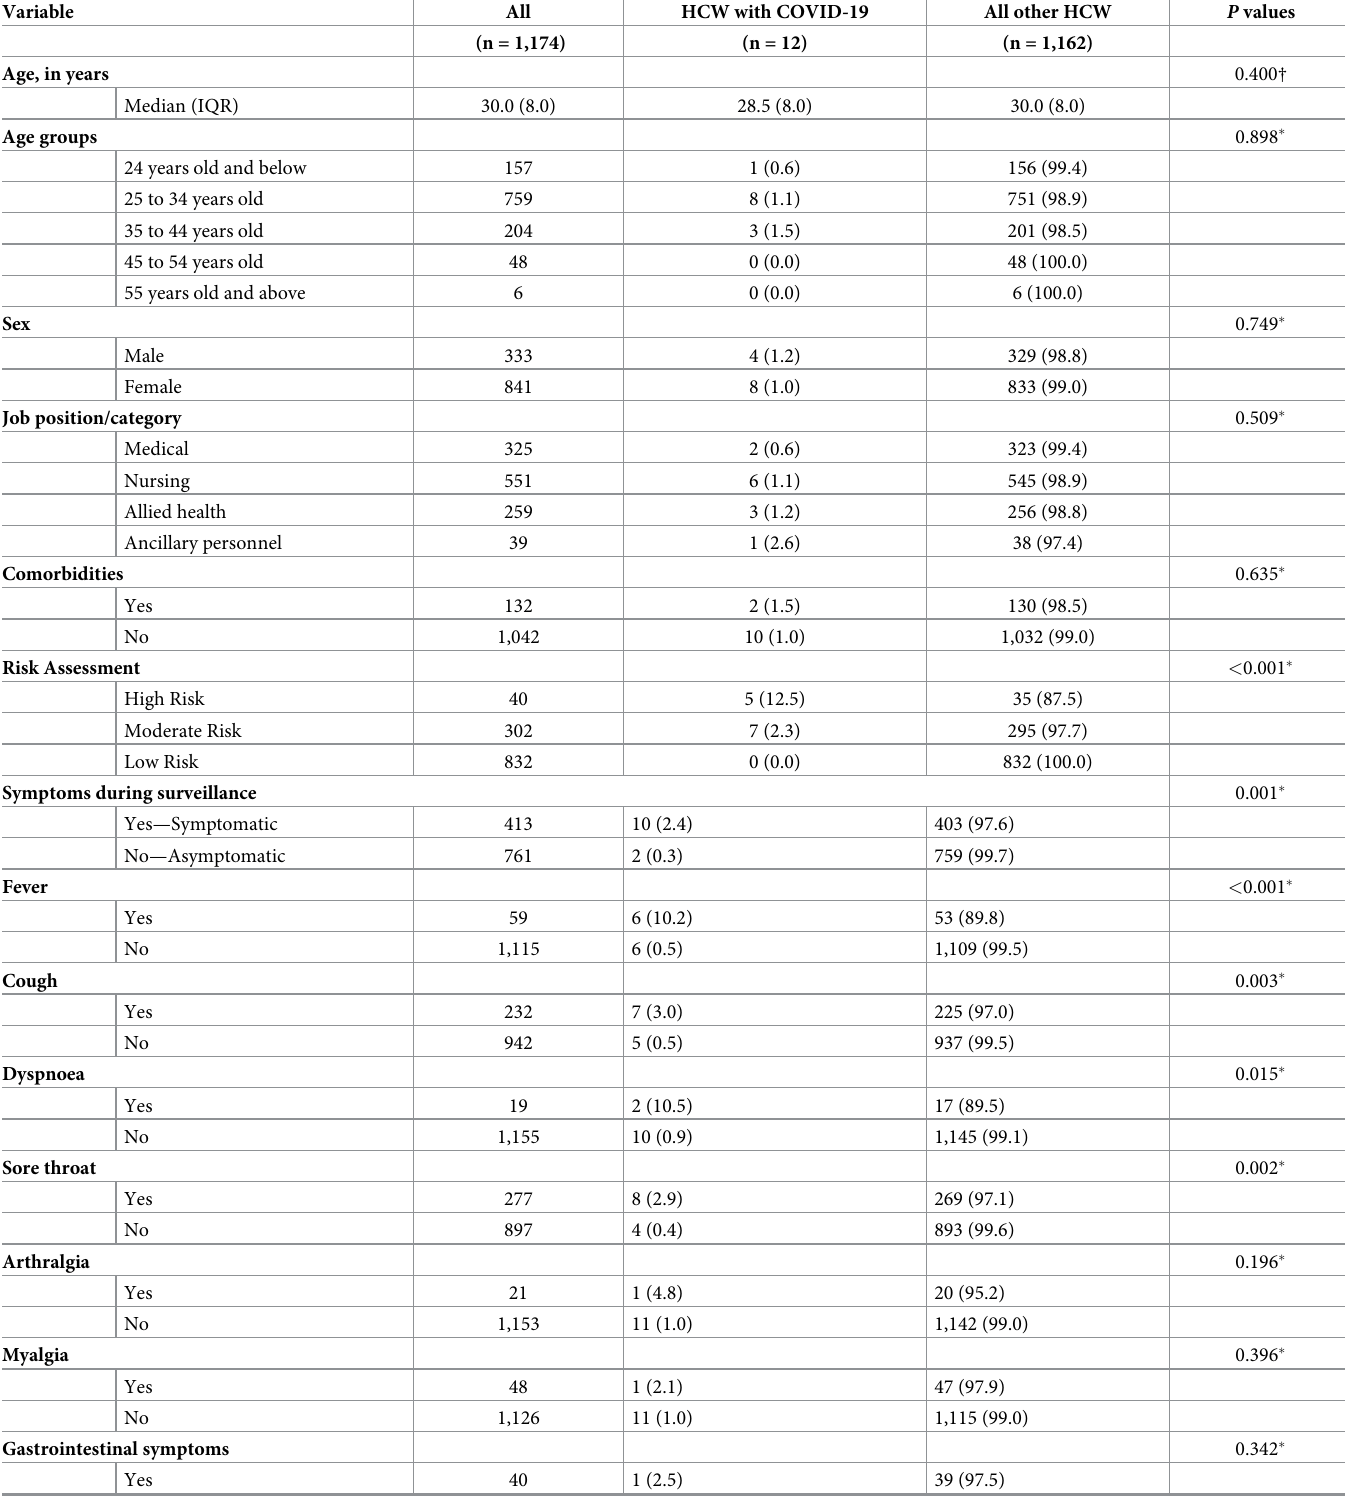
Table 3. Univariable analysis for baseline characteristics and surveillance variables (n =